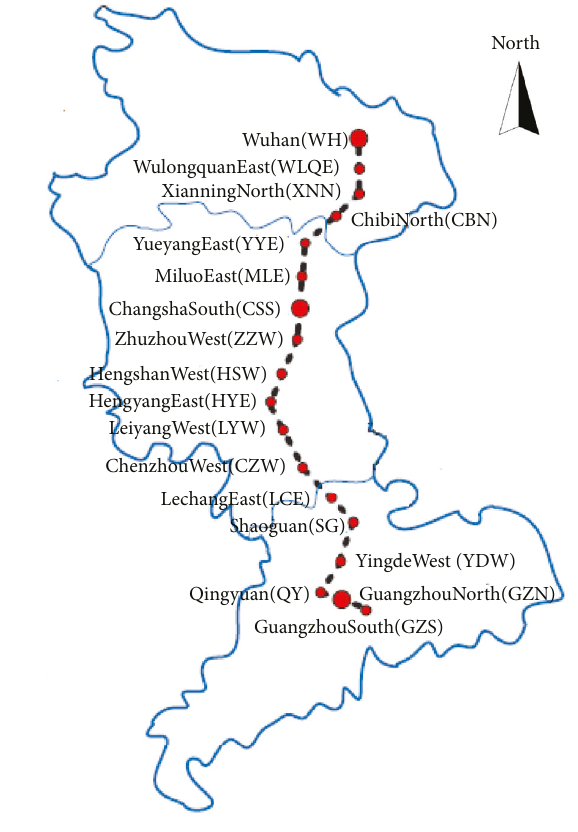
Figure 1: Map of W-G HSR